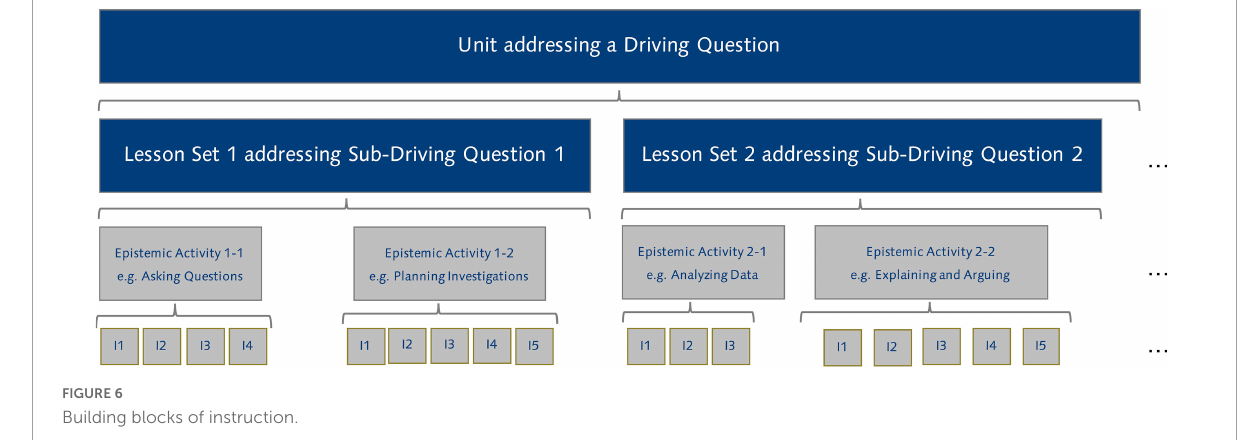
FIGURE6 Building blocks of instruction.